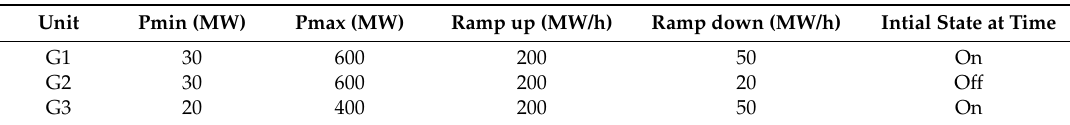
Table 3. Thermal generator data.